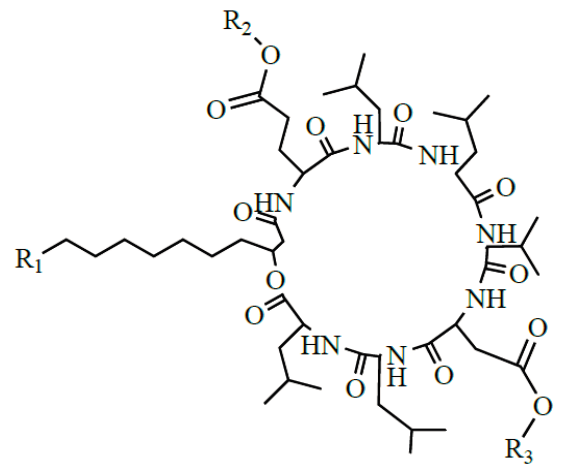
Figure 9. The structures of E1, E2 and E3. E1: R 1 = C 5 H 11 , R 2 = CH 2 –CH 2 –O–CH 3 , R 3 = H